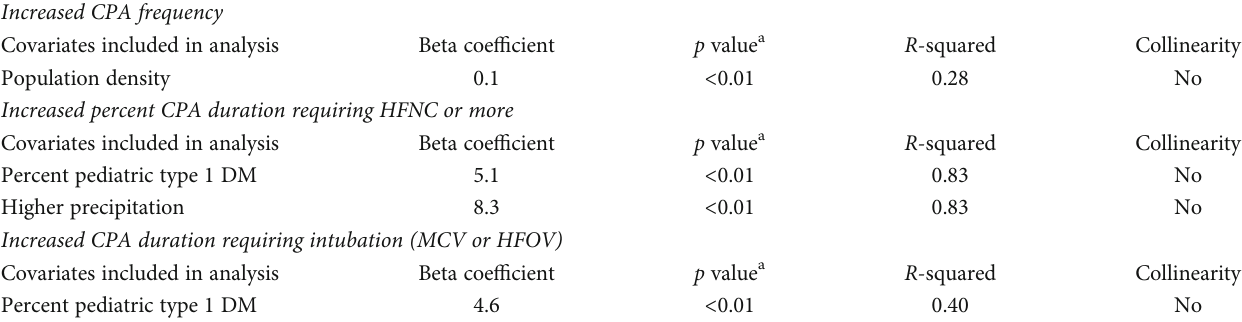
Table 3: Multivariate regression